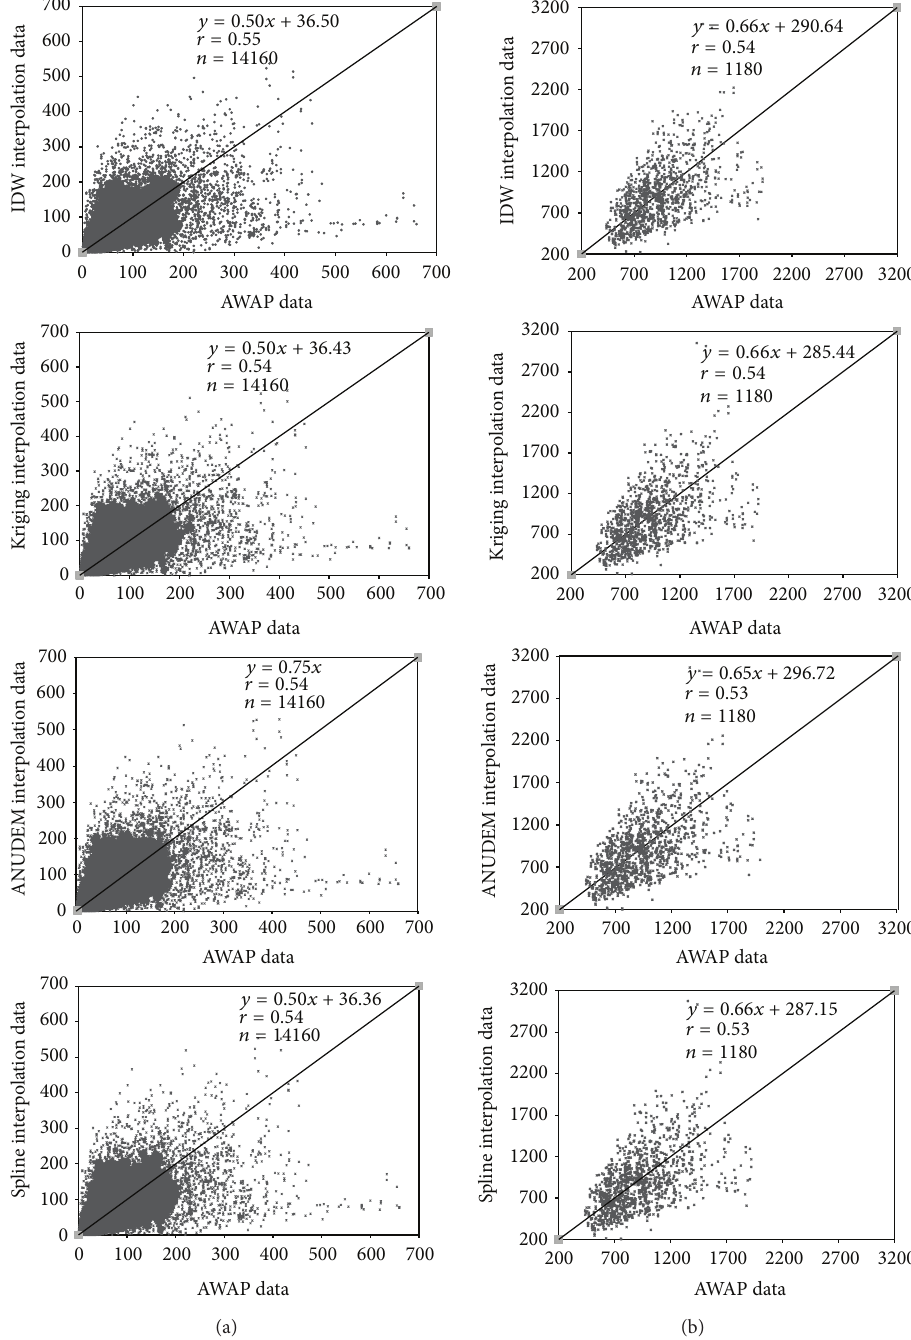
Figure 2: Scatter plots of correlation between interpolation and AWAP for monthly rainfall (a) and annual rainfall (b).